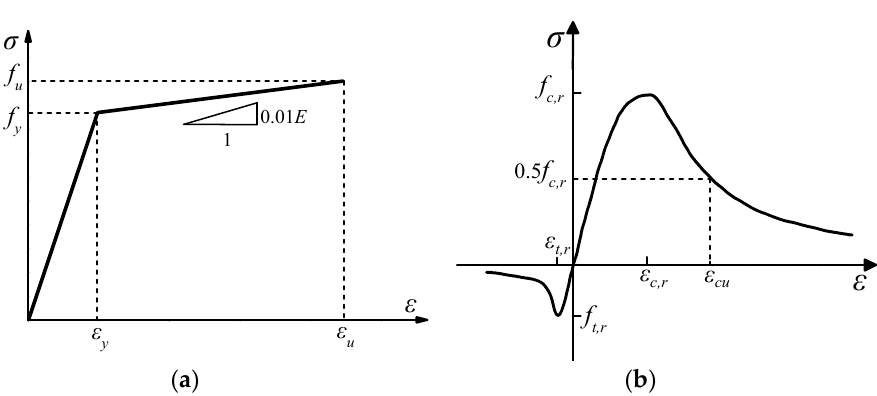
Figure 10. The stress-strain curve of materials. ( a ) Steel tube; ( b ) concrete.